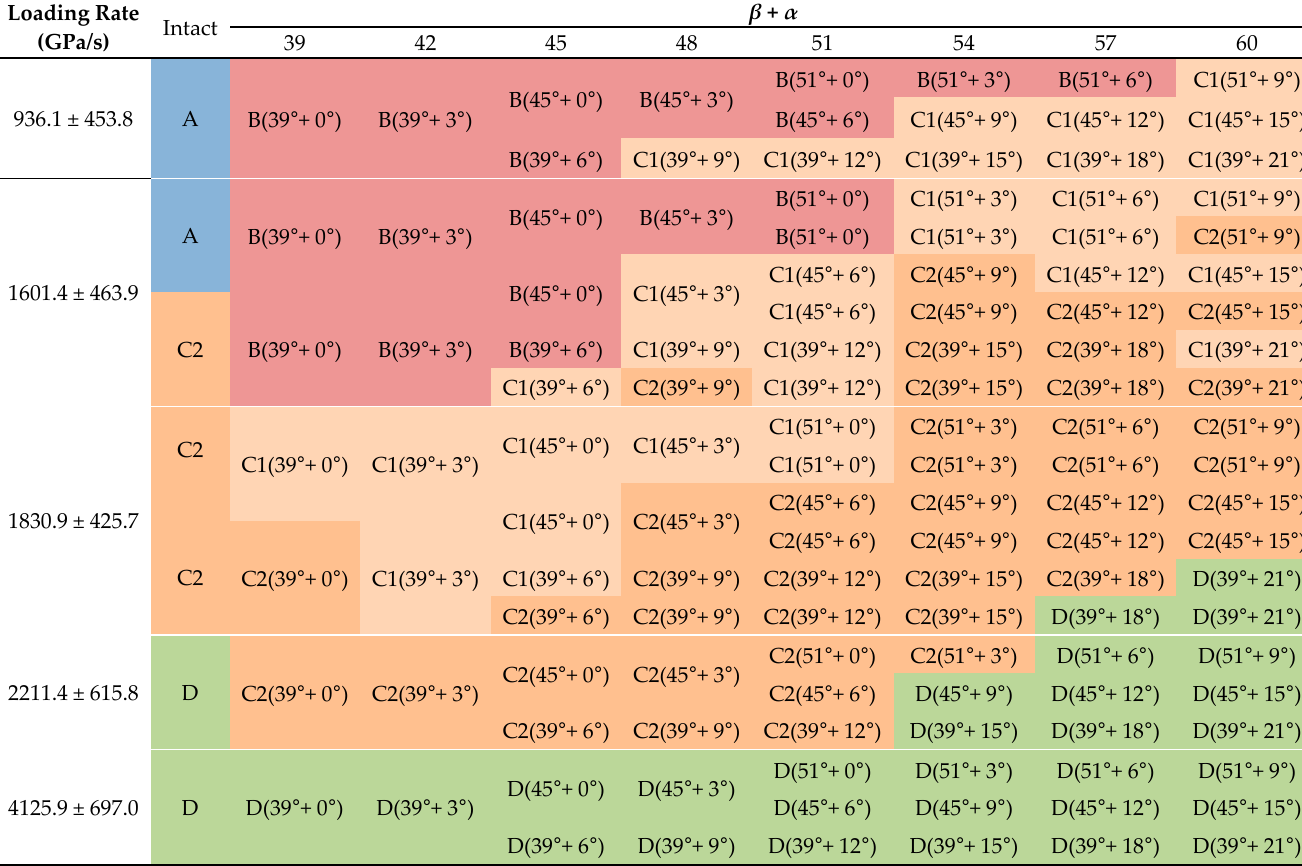
Table 3. Classification of failures of specimen in the SHPB test.